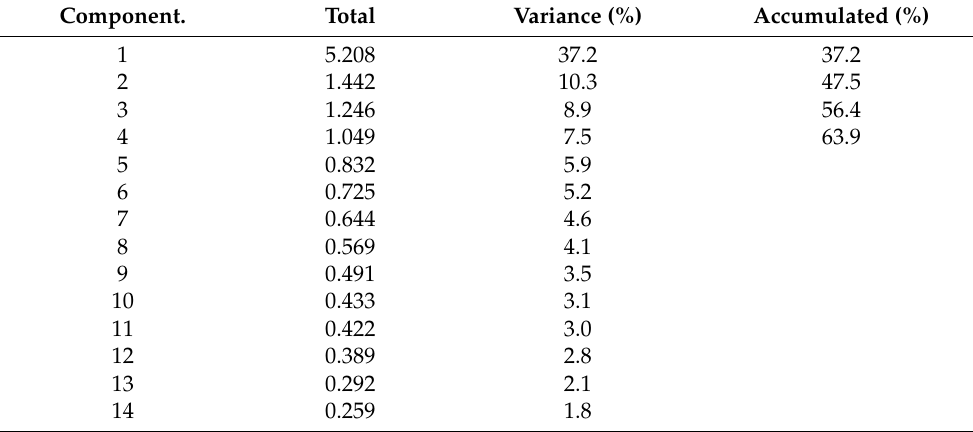
Table 3. Total explained variance.